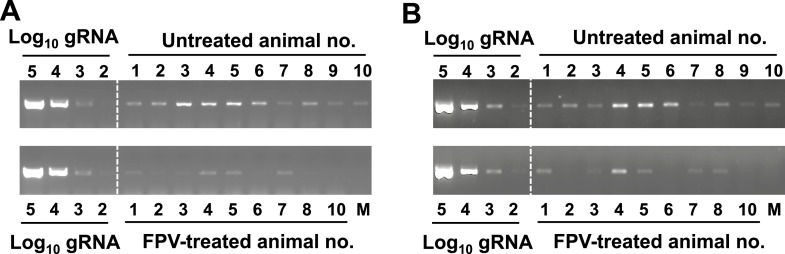
Semi-quantitative analysis of viral RNA in favipiravir-treated and control mice.Viral RNA was extracted and reverse transcribed as described in ‘Materials and methods’ (Arias et al., 2012a). Standard curve was obtained with known amounts of in vitro transcribed MNV-3 RNA (102 to 105 genome equivalents) that were PCR amplified after reverse transcription. (A) RT-PCR amplification of faecal samples isolated from animals treated during 53 days with favipiravir or placebo. RNA isolated in 50 μg of faeces was RT-PCR amplified and agarose-gel resolved as explained above. (B) RT-PCR amplification of RNA extracted from colon samples isolated from animals treated for 8 weeks with favipiravir or placebo. 50 ng of RNA isolated from different animal colon tissues were RT-PCR amplified as explained above.